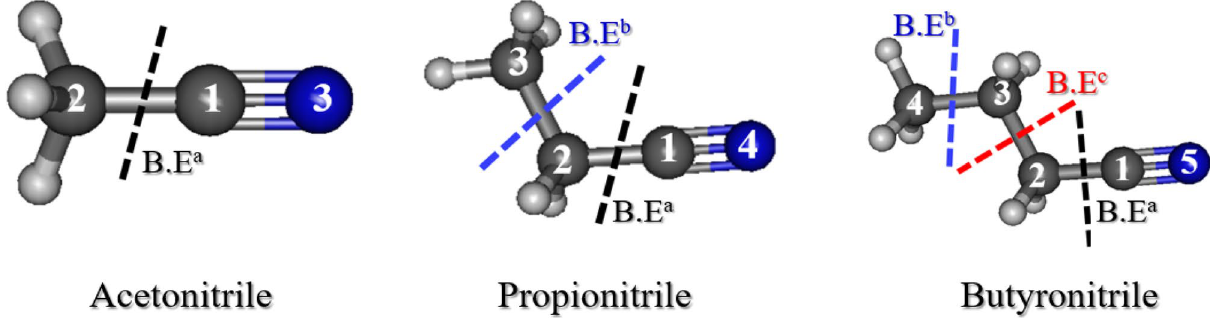
Figure 7. Structures of organic nitrile solvents showing the separated bonds, for which the binding energy (BE) was calculated. BE a —bond between the C 1 and C 2 atoms (C 1 –C 2 in all nitriles), BE b —bond between two carbon atoms (C 2 –C 3 in propionitrile or C 3 –C 4 in butyronitrile), BE c —bond between the C 3 and C 2 carbon atoms (C 3 – C 2 ) in butyronitrile.